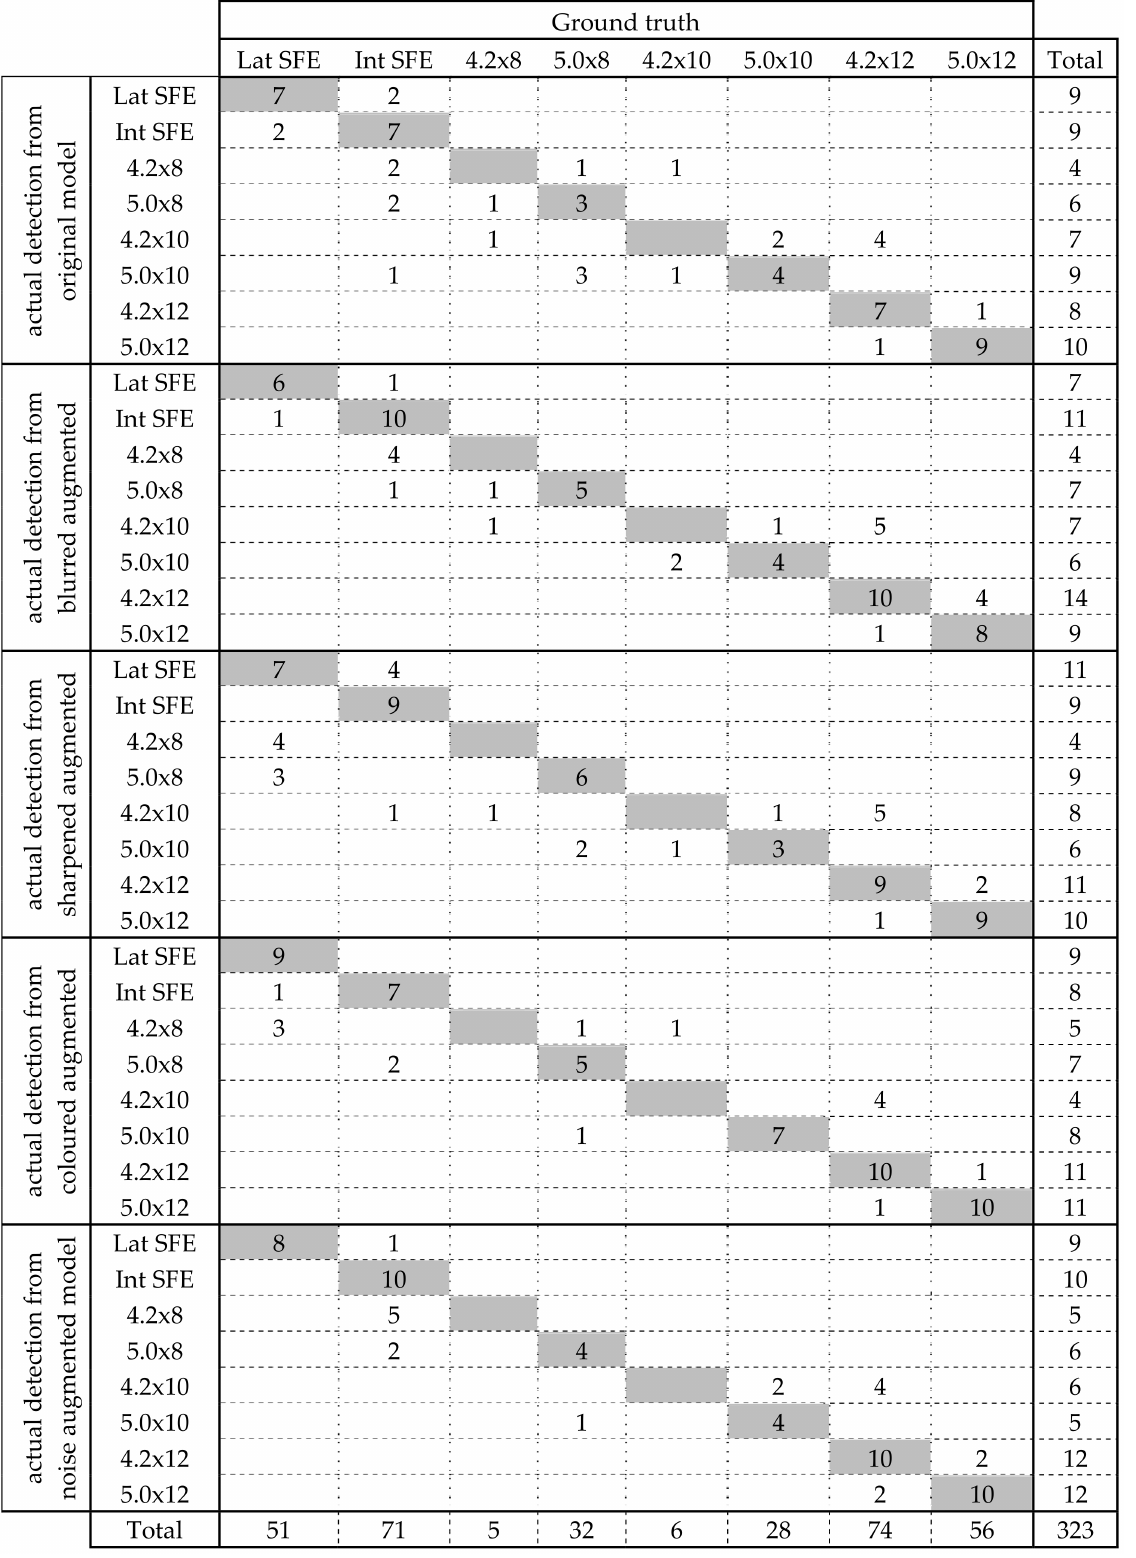
Figure 6. The confusion matrix table between each detection in each model for the cross-sectional images. The performance of the detection in all models was incorporated into the learning curve, which are displayed in Figure 7a,b. The learning curve of the original